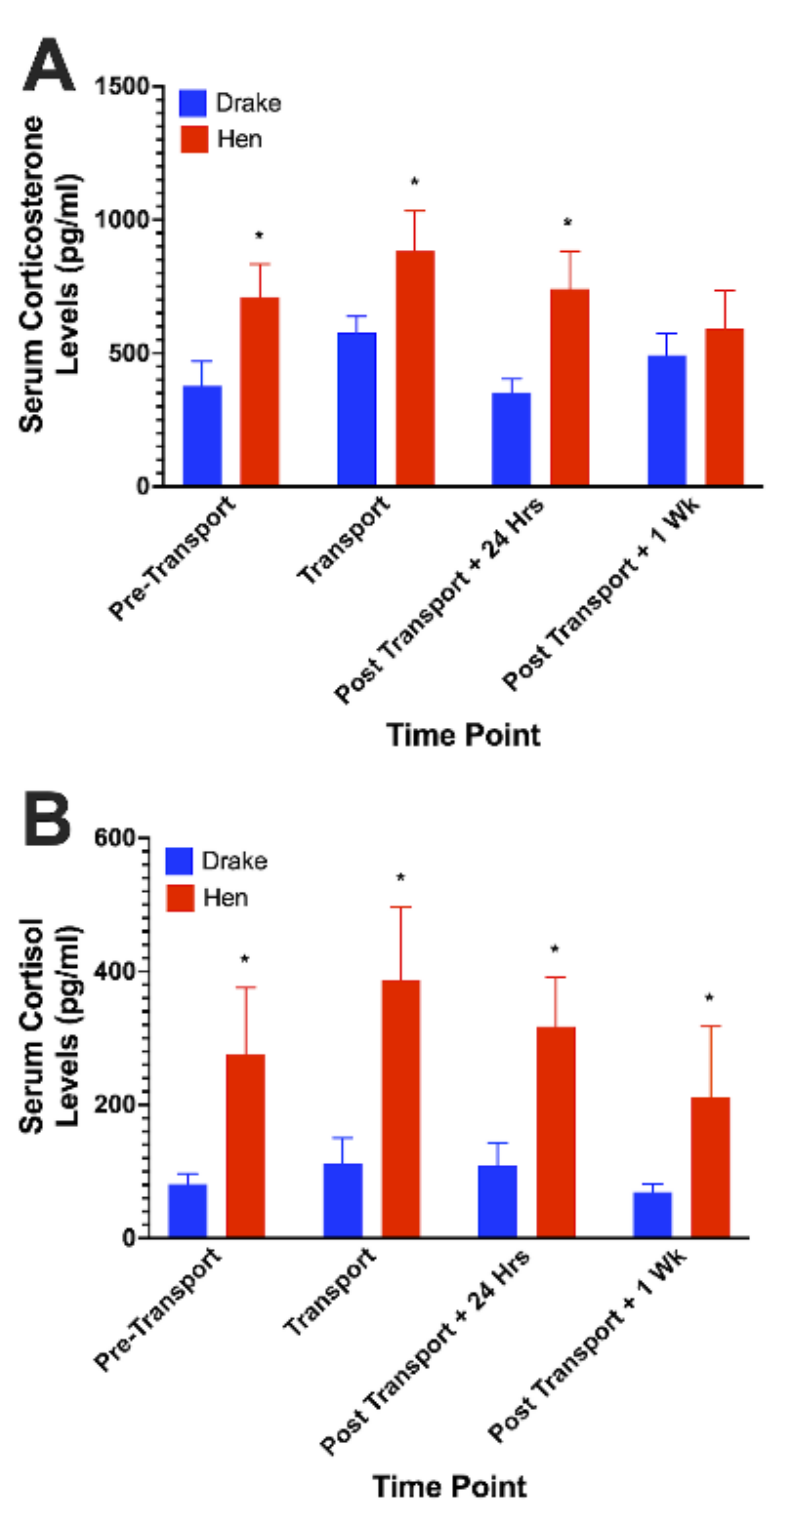
Figure 1. Serum glucocorticoids in ducks following transportation stress. Sex differences were observed in that hens showed significantly greater levels of both circulating corticosterone ( A ) and cortisol ( B ) compared to drakes. Transportation elicited a non-significant increase in both glucocorticoids. The lack of significant increase may likely be due to the timing of blood sampling relative to the perceived onset of stress. * = p < 0.05.